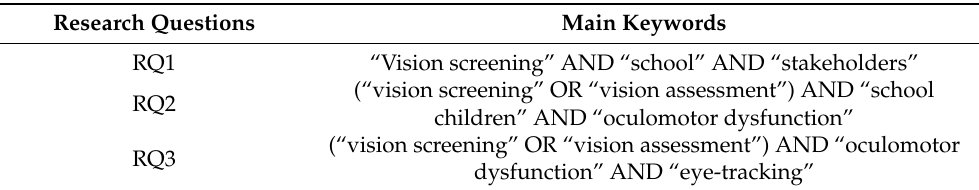
Table 2. Keywords guided the search of the literature for each research question. Research